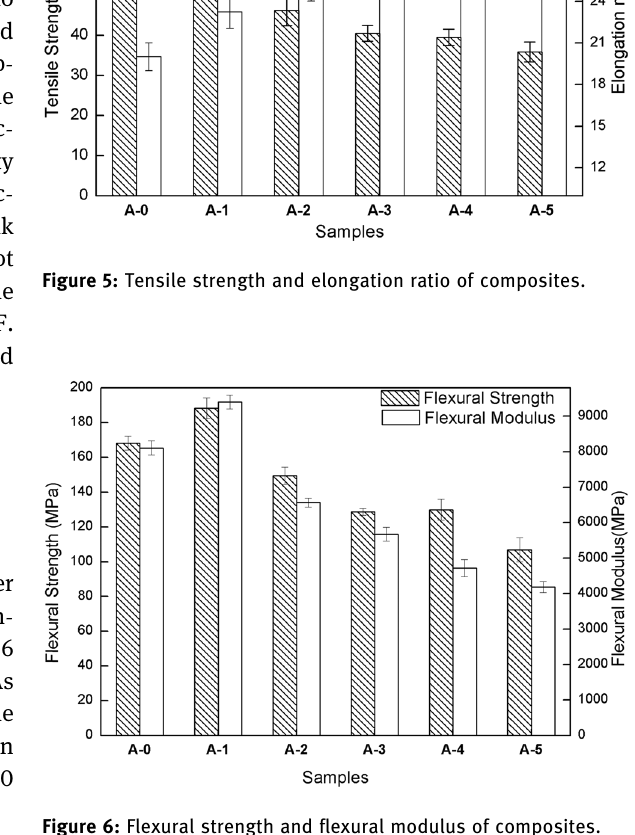
Figure 6: Flexural strength and fl exural modulus of